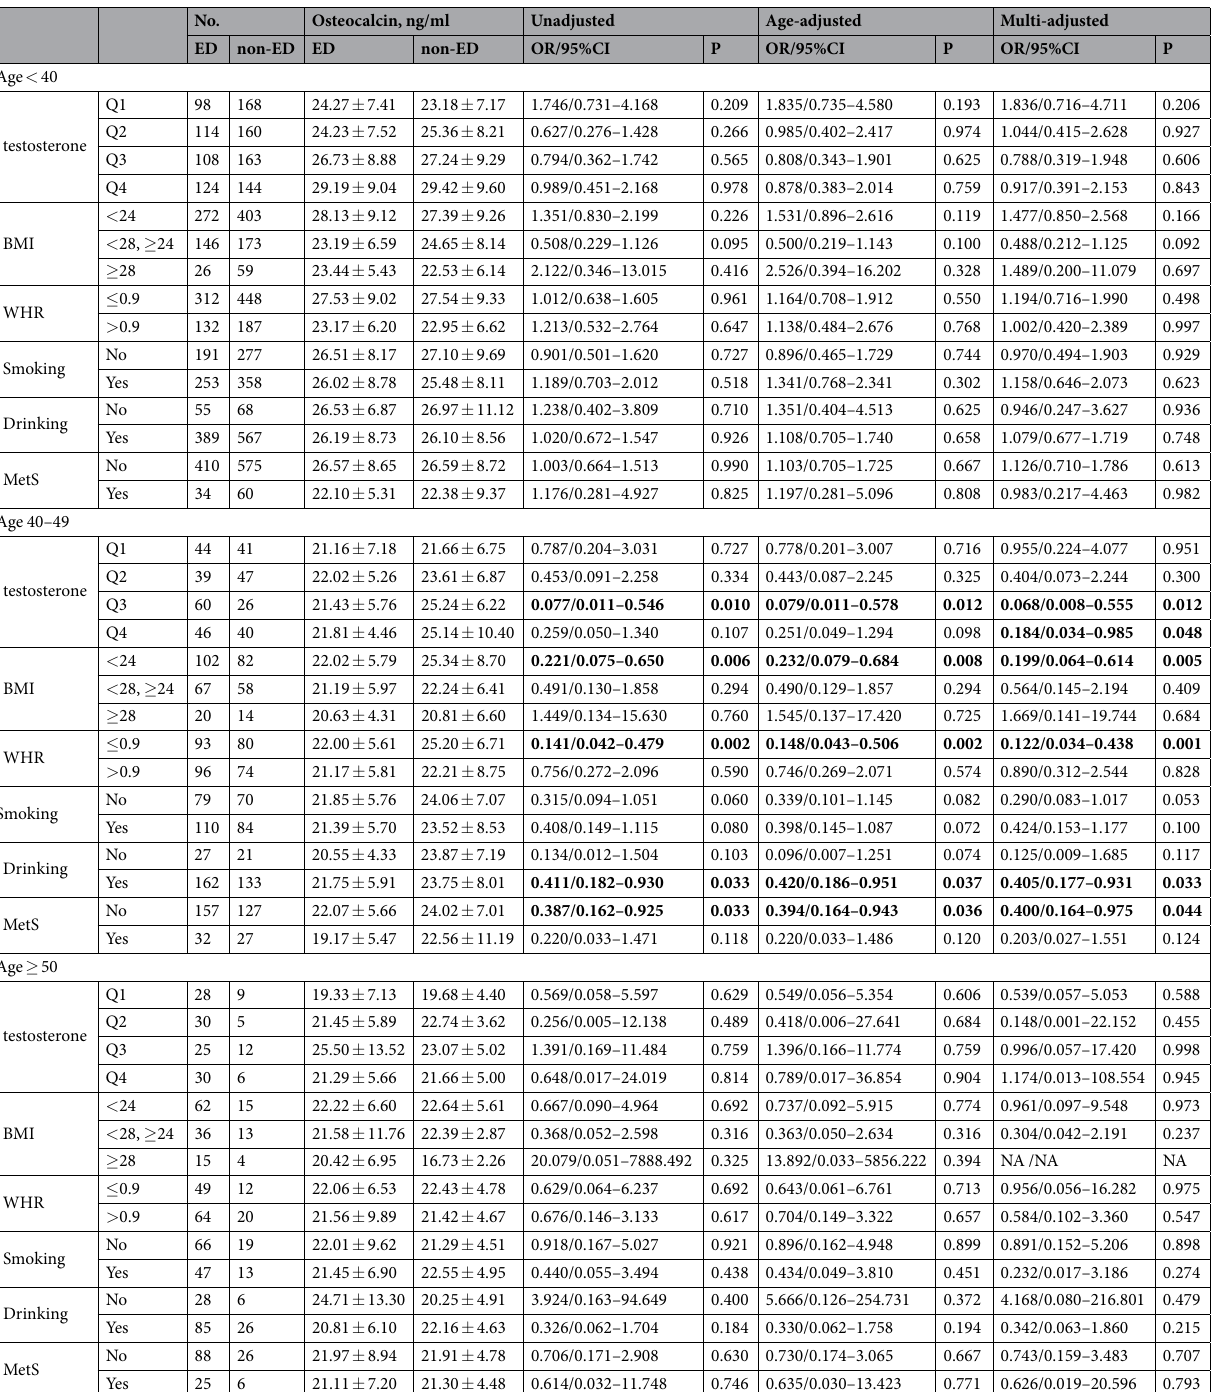
Table 6. The logistic regression analysis for the association between ED and osteocalcin in various groups. * Testosterone levels are divided into quartile (Q1 < levels of 25%, 25% ≤ Q2 ≤ 50%, 50% < Q3 ≤ 75%, Q4 > 75%) in different ages. * BMI is categorized into three groups (normal weight < 24.0 kg/m 2 , overweight 24.0–27.9 kg/m 2 , obese 28.0 kg/m 2 ). Meanwhile, the waist-hip ratio (WHR) is categorized as normal weight (WHR ≤ 0.9) and obese (WHR > 0.9). * Smoking, drinking and metabolic syndrome (MetS) are considered as dichotomous variable (Yes/No). * ED is considered as dichotomous variable (ED/without ED). Then, binary logistic regression analyses are conducted for every subgroup, in which ED is treated as the dependent factor. And the level of osteocalcin is treated as covariate. * The level of osteocalcin (ng/ml) is presented as mean ± SD in the ED and non-ED groups. * ED: erectile dysfunction; BMI: body mass index; WHR: waist hip rate; OR: odd ratio; 95%CI: 95% confidence interval; MetS: metabolic syndrome. * Multi-adjusted: age, BMI, WHR, smoking and